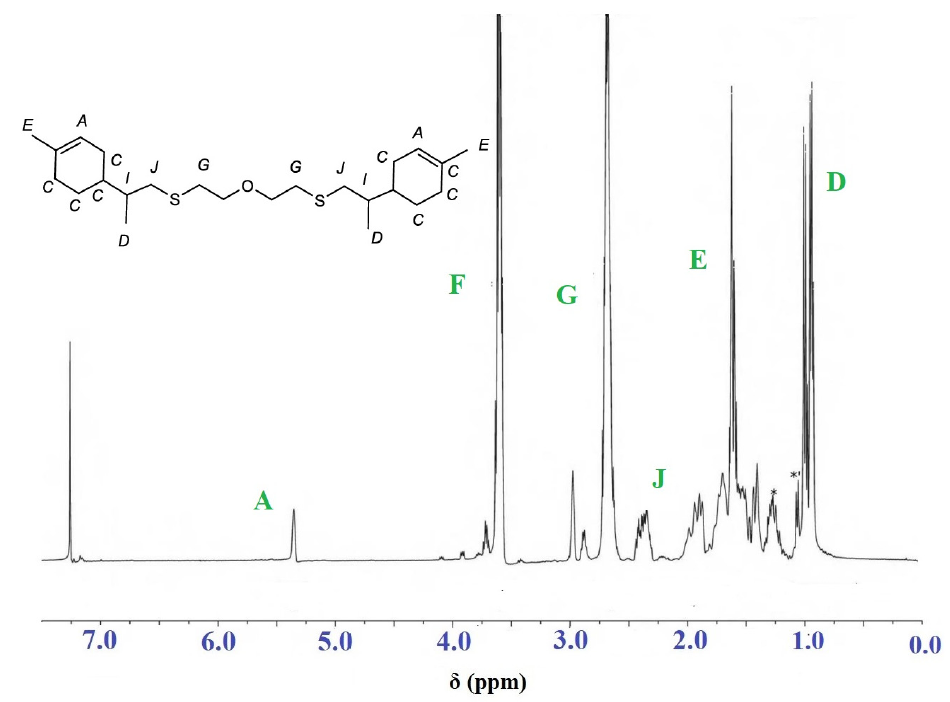
Figure 10. 1 H-NMR spectrum of the polymerization product of limonene and 2-mercaptoethyl ether with AIBN as initiator .